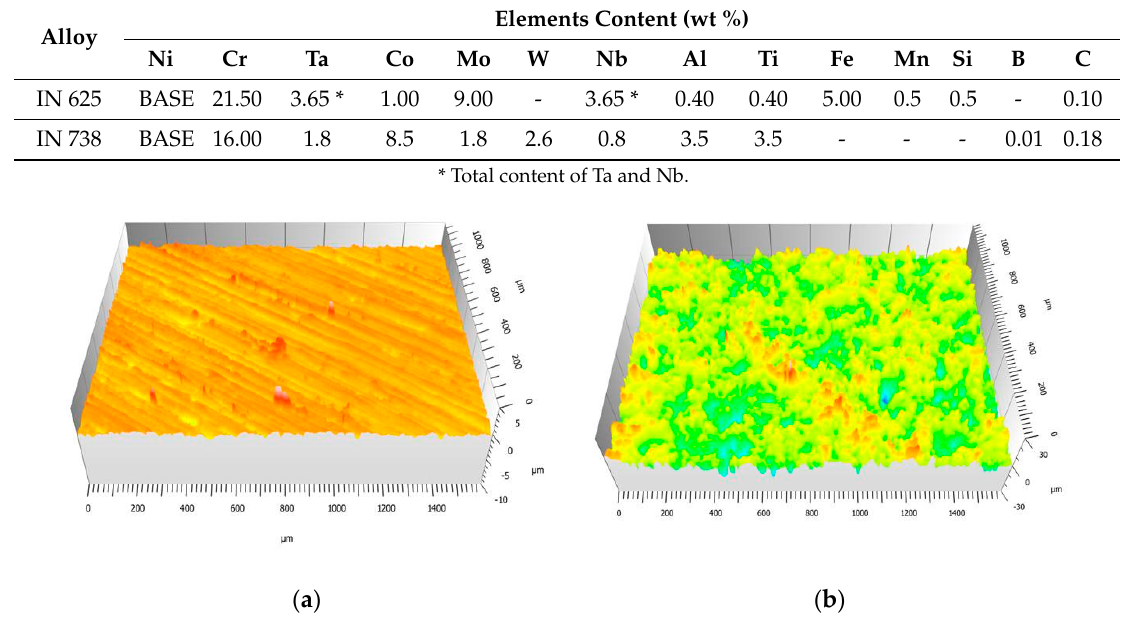
Figure 1. Reproduction of the: ( a ) Ground and ( b ) grit-blasted surfaces topography of the IN 625 substrate prior to the chemical vapor deposition (CVD) aluminizing process.